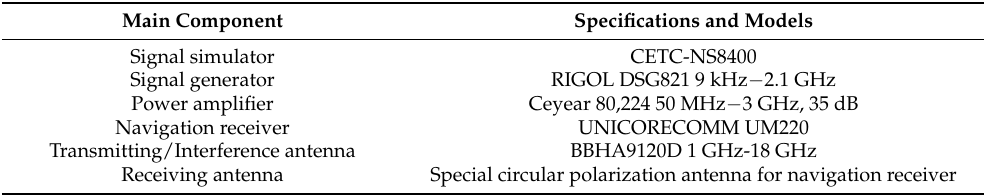
Figure 3. Configuration of sensitivity testing on navigation receiver. Table 2. The specifications and models of main components in experiment system.